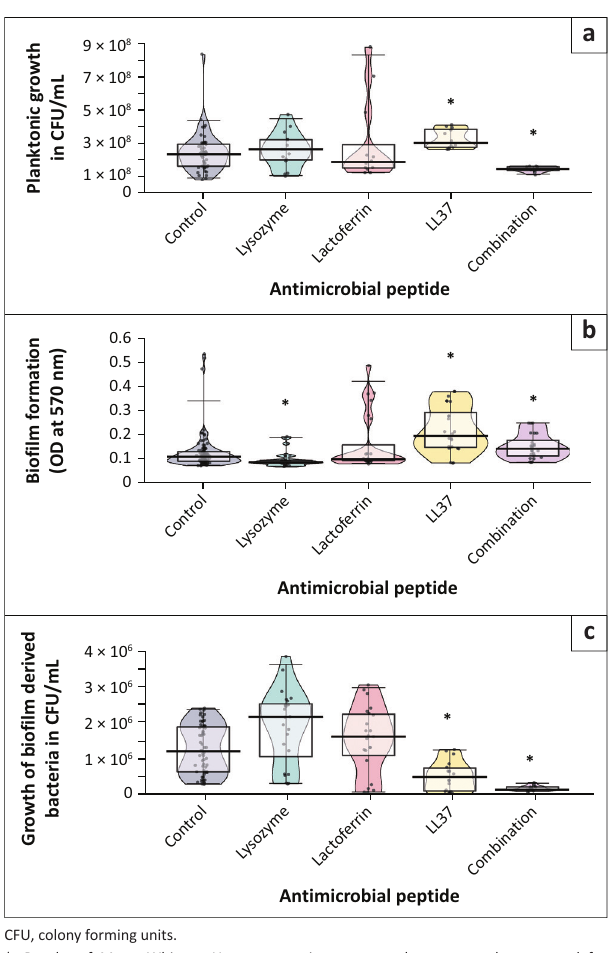
FIGURE 1: The effects of antimicrobial peptides alone and in combination on planktonic growth (a), biofilm formation (b), and biofilm-derived bacterial viability (c) of S. pneumoniae strain 172. Lysozyme (100 micrograms per millilitres [µg/mL]), lactoferrin (70 µg/mL) and LL37 (20 µg/mL). The results of three to four experiments with three to six replicates per system are presented as the pirate plots, with the median and interquartile range